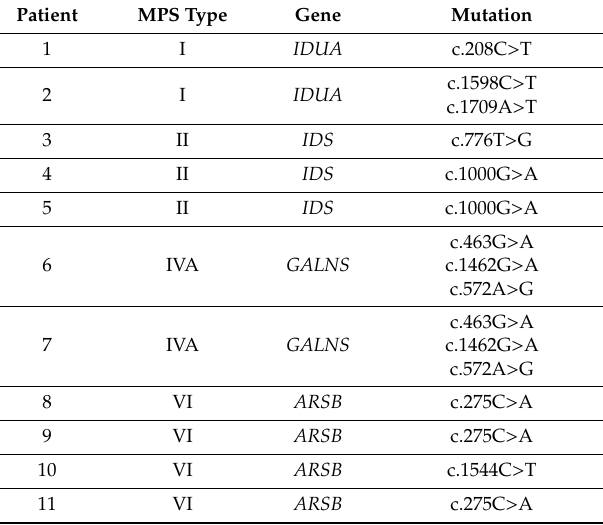
Table 2. Genetic characteristics of the study